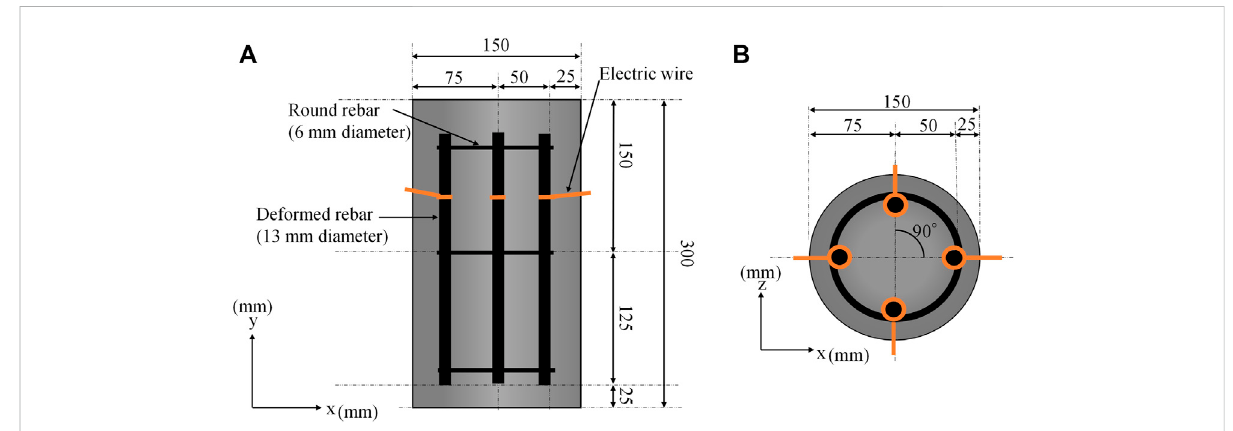
FIGURE 2 Size and reinforcement of cylinders (A) longitudinal view and (B) transverse view.